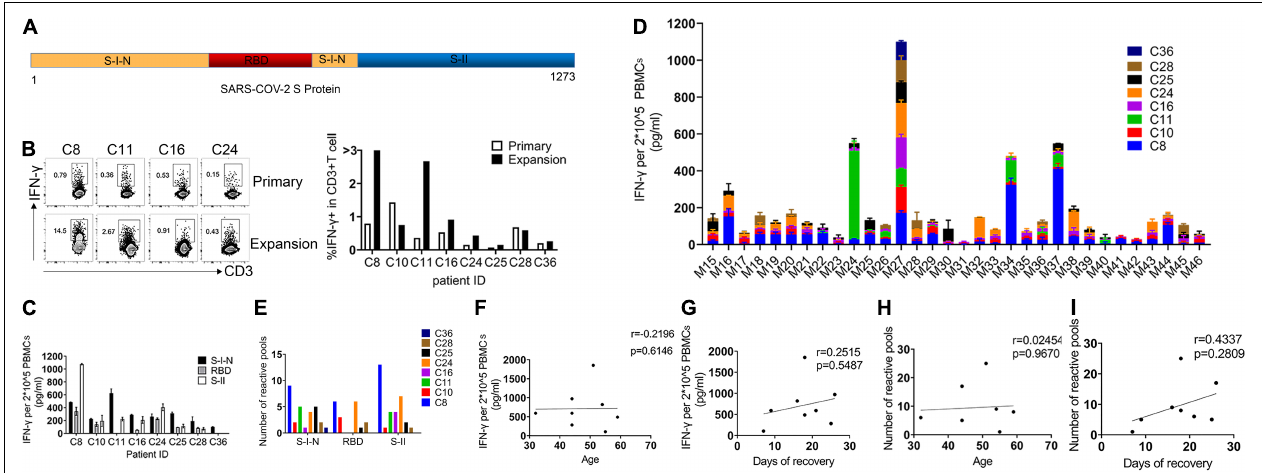
FIGURE 2 | Severe Acute Respiratory Syndrome Coronavirus 2 spike glycoprotein-reactive T cells in recovered COVID-19 patients. (A) The structural of SARS-COV-2 spike glycoprotein: the N-terminal of S protein is called S-I, including RBD and non-RBD regions (S-I-N), and the C-terminal of the S protein is called S-II. (B) FC was used to detect the frequency of SARS-CoV-2 S-specific T cells (CD3 + IFN- γ + ) before and after expansion. (C) The IFN- γ production in PBMCs of each individual was detected by ELISA after stimulation with SARS-COV-2 S peptides (24 h). A total of 2 × 10 − 5 PBMCs were stimulated with complex Mix pools of different regions of SARS-COV-2 S protein: S-I-N (Mix21-31), RBD (Mix15-20), or S-II (Mix32-46). (D) The magnitude of T cell response for each individual to a single Mix pool. (E) The breadth of T cell response for each individual to different regions of SARS-COV-2 S protein. The breadth of T cell response was calculated by the number of positive Mix pools. The number of positive mix pools = IFN- γ /DMSO > 2. (F–I) The correlation analyses of magnitude and breadth of T cell responses versus patients’ age (F,H) and the time of recovery (G,I) . The quantitative results are shown as the mean ± SD of at least two independent experiments. SARS-CoV-2, severe acute respiratory syndrome coronavirus 2; RBD, receptor-binding domain; FC, flow cytometry; PBMCs, peripheral blood mononuclear cells; IFN- γ , interferon- γ ; ELISA, enzyme linked immunosorbent assay; Mix,